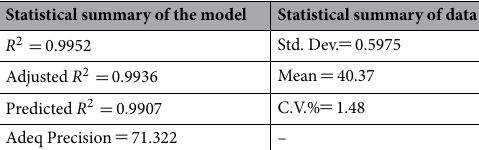
Table 10. The descriptive statistics of the proposed model for